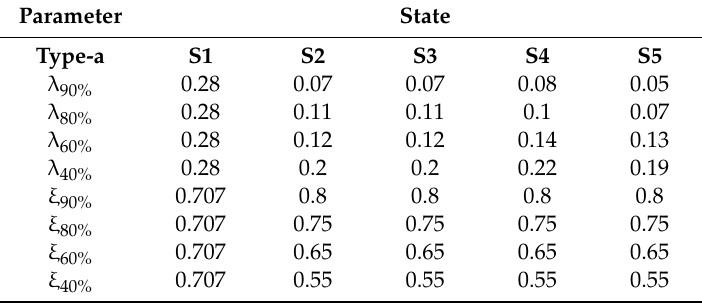
Figure 8. Transient responses to a 90% depth type-a voltage sag. In blue: SOGI-FLL. In red: SOGI-FLL with saturation. In green: FSM-based SOGI-FLL.